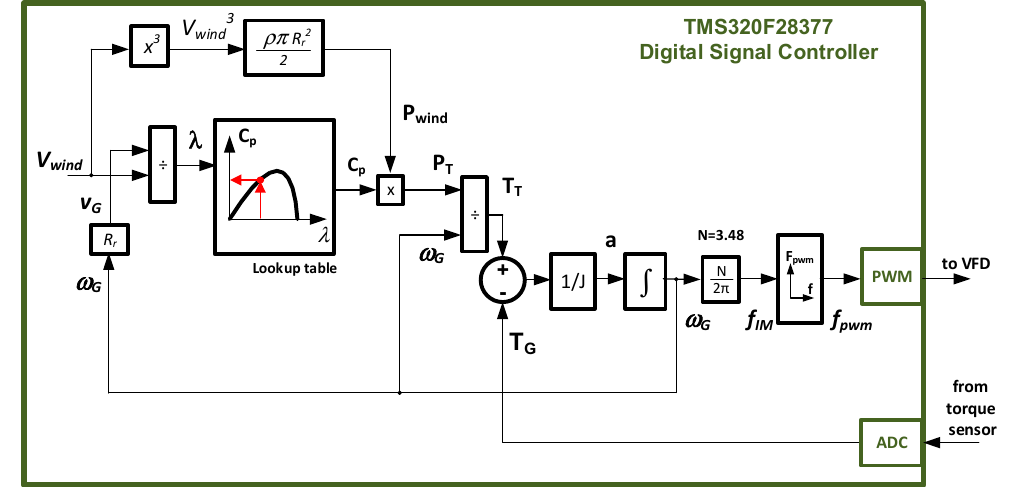
Figure 15. Block diagram of the proposed wind turbine emulator algorithm.